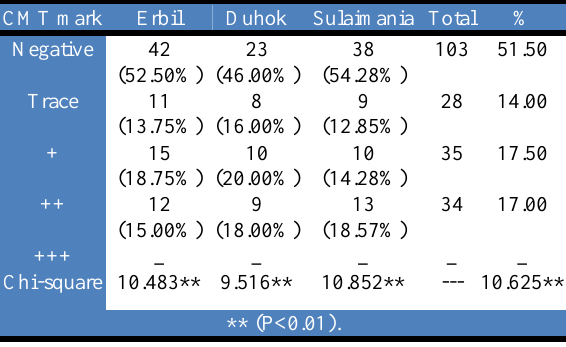
Table, 3: The CMT test to all goats' milk samples in all governorate. .